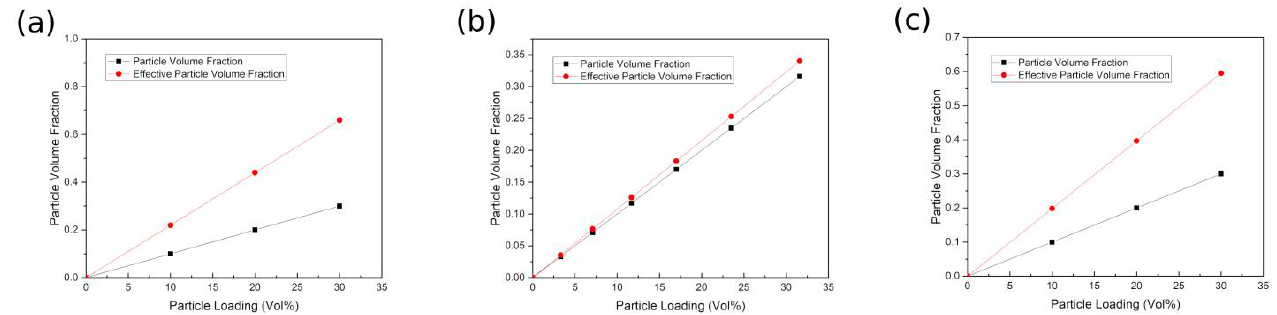
Figure 3. Comparison of particle volume fraction and effective particle volume fraction of poly- mer-based nanocomposites ( a ) BaTiO 3 -epoxy resin ( b ) Al 2 O 3 -epoxy resin ( c ) BaTiO 3 -epoxy resin.